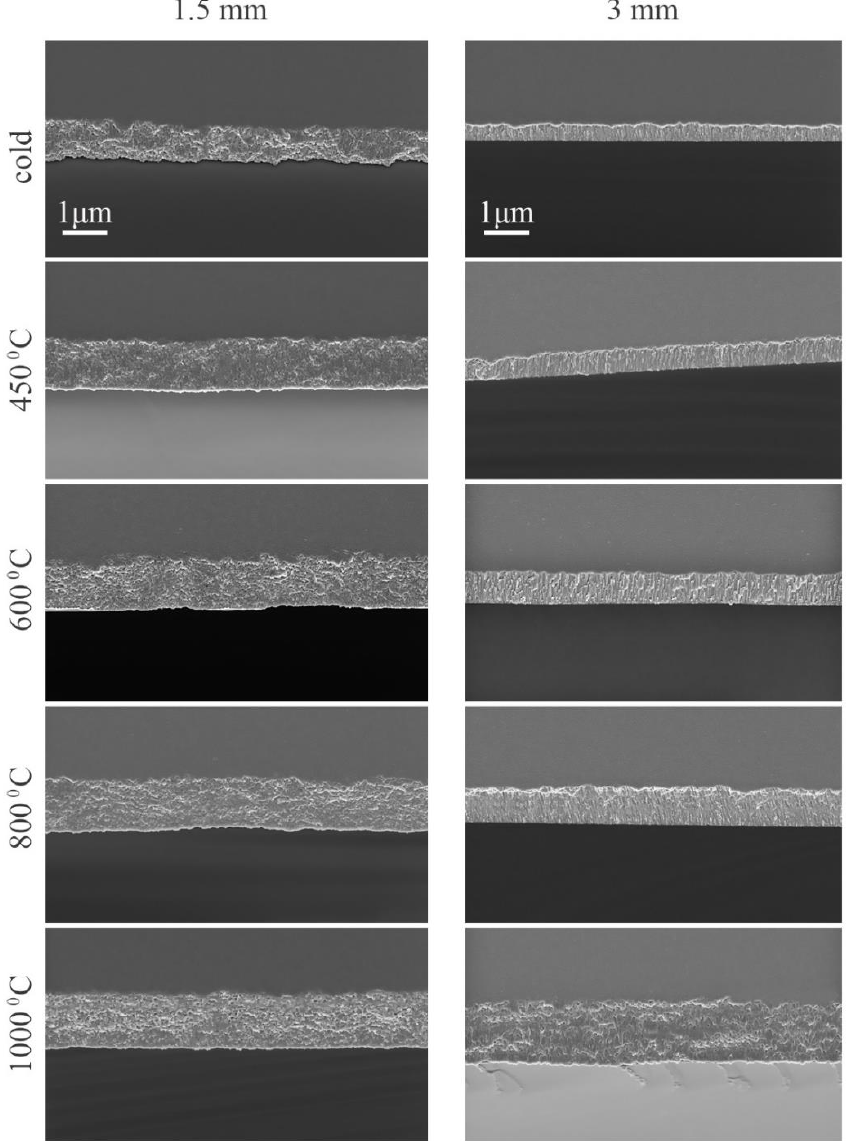
Figure 6. SEM images of nickel coatings structures deposited during the sputtering at various tem- peratures .